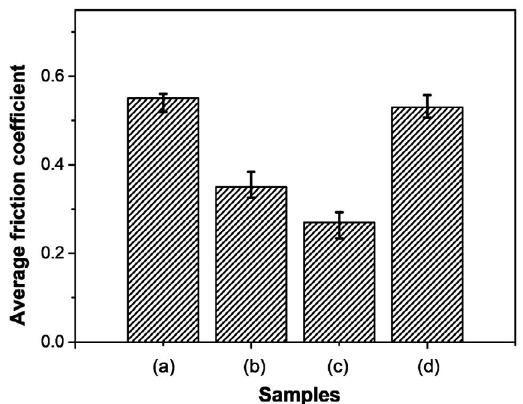
Figure 6. Average friction coefficient of (a) Ni-P; (b) Ni-P/Ni-P; (c) Ni-P-12.5mL/L TiO /Ni-P; (d) Ni-P-50mL/L TiO 2 Fig. 7 shows the wear track images of Ni-P